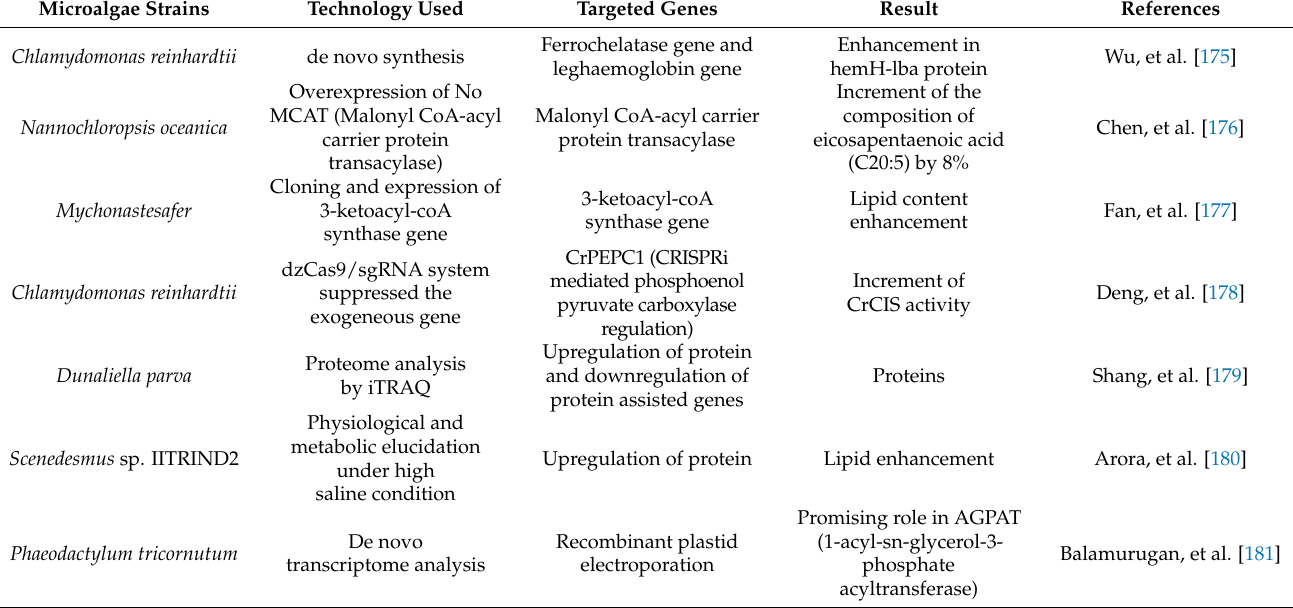
Table 6. Microalgal strains used for the study of algomics approach towards their improvement in lipid